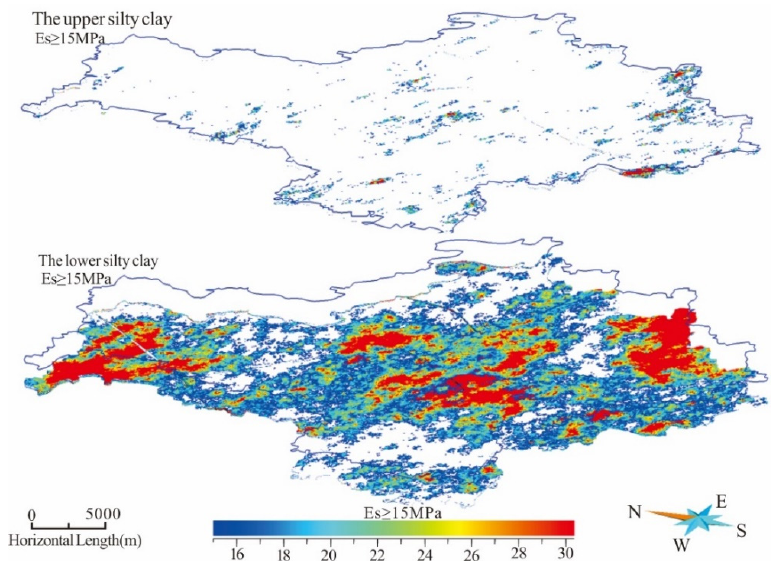
Figure 19. The upper (23) and lower silty clay units (43) with E s values larger than 15 derived from the 3D property model.